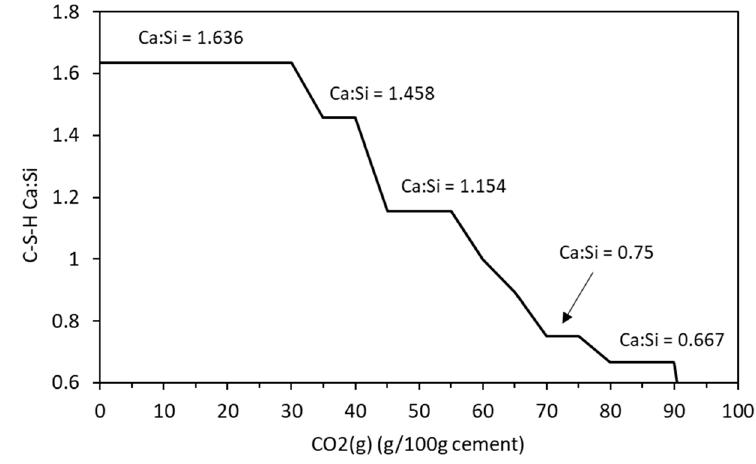
Figure 5. Change in C-S-H Ca:Si ratio with increasing CO 2 content.